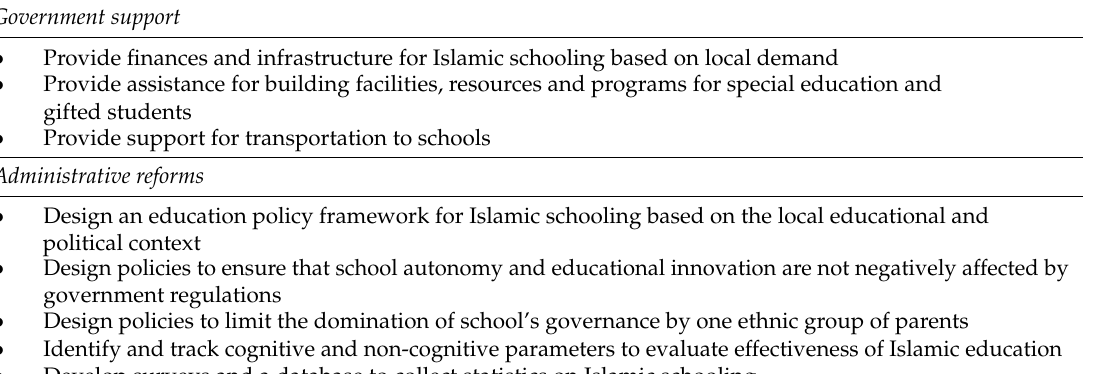
Table 5. List of suggested policies to improve the quality of Islamic